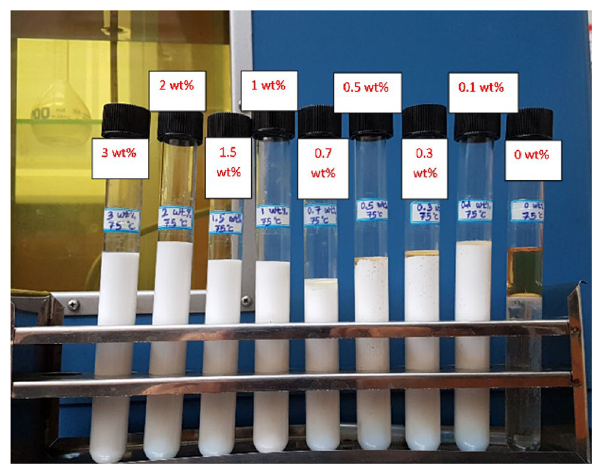
Fig. 15 Photographs of emulsions with various SDS concentrations after around 6